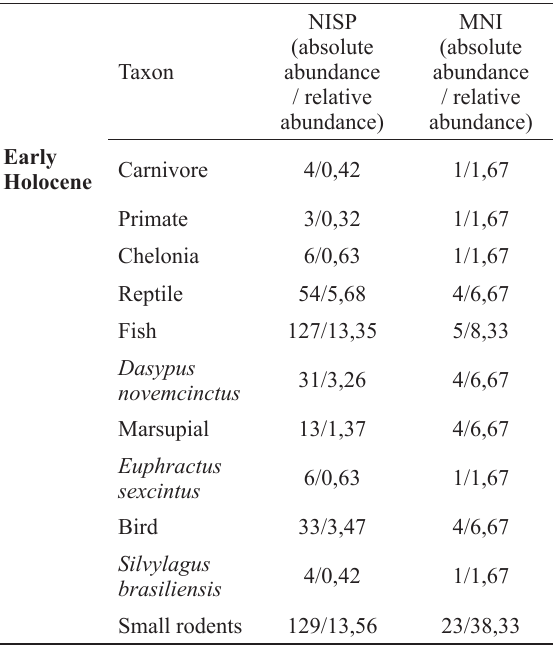
Absolute and relative (%) abundance of taxa calculated from NISP and MNI, for the Early and Middle Holocene levels. NUSP: Number of Unidentifiable Specimens, after Perez (2009).